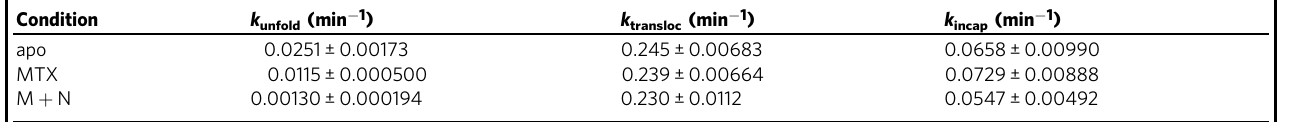
Table 1 Summary of fi t parameters from analyzing real-time translocation measurements.